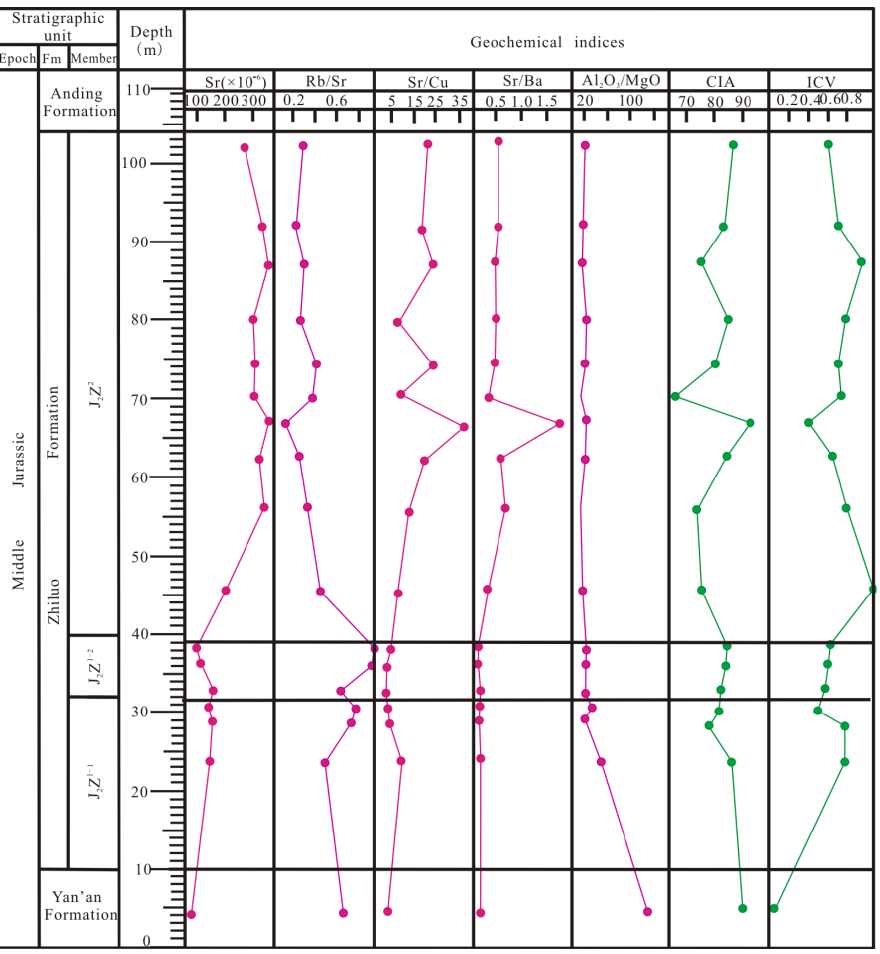
Figure 6. The vertical variation map of the geochemical parameters of Jurassic Zhiluo Formation mudstones in the Shenshangou area of Ordos Basin (modified after [21,22]).